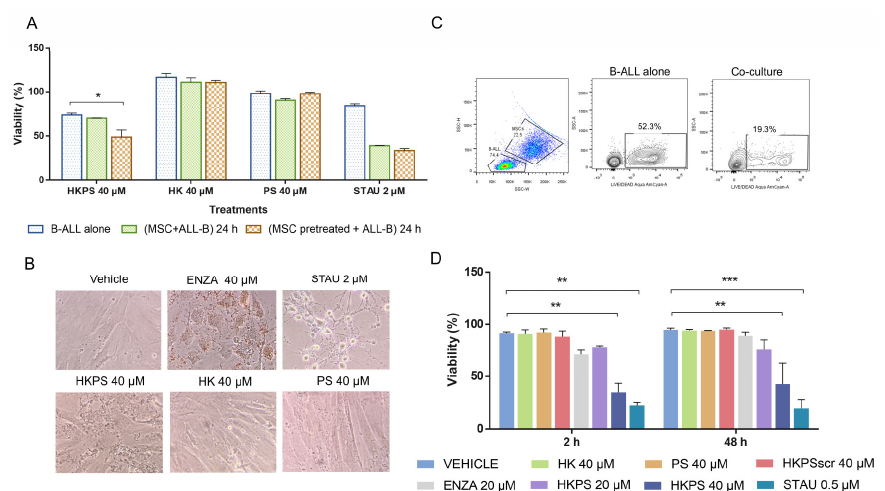
Figure 3. The inhibition of the stromal support by HKPS increases B-ALL leukemic cell death. ( A ) Representative response in the intermediate HKPS susceptible group to peptides treatment (40 µM) and STAU (2 µM) under the following conditions: B-ALL cells alone for 2 h without support; co-cultures of B-ALL cells and MSC for 2 h and then cultured for additional 22 h in the presence of 10% FBS; pre-treatment of MSC for 2 h and then co-cultures with untreated leukemic cells for additional 22 h. Results represent one of three independent experiments. ( B ) Morphological changes of MSC after treatment with HK, PS or HKPS peptides, and ENZA or STAU inhibitors at the indicated concentrations. Representative microphotographs are shown at 20× magnification. ( C ) Effect of MSC support in B-ALL cell viability assessed by LIVE/DEAD Aqua staining by flow cytometry. ( D ) MSC were treated for 2 h or 48 h in the presence of 1% FBS with HKPS, the control peptides and PKC inhibitors ENZA and STAU (20 µM and 0.5 µM, respectively) and then co-cultured for 72 h with primary B-ALL cells. Viability was determined in the leukemic cell population by flow cytometry. Data are expressed as mean ± SEM obtained from two independent experiments ( p values non-parametric one-way ANOVA * p < 0.05. ** p < 0.01. **** p < 0.001).